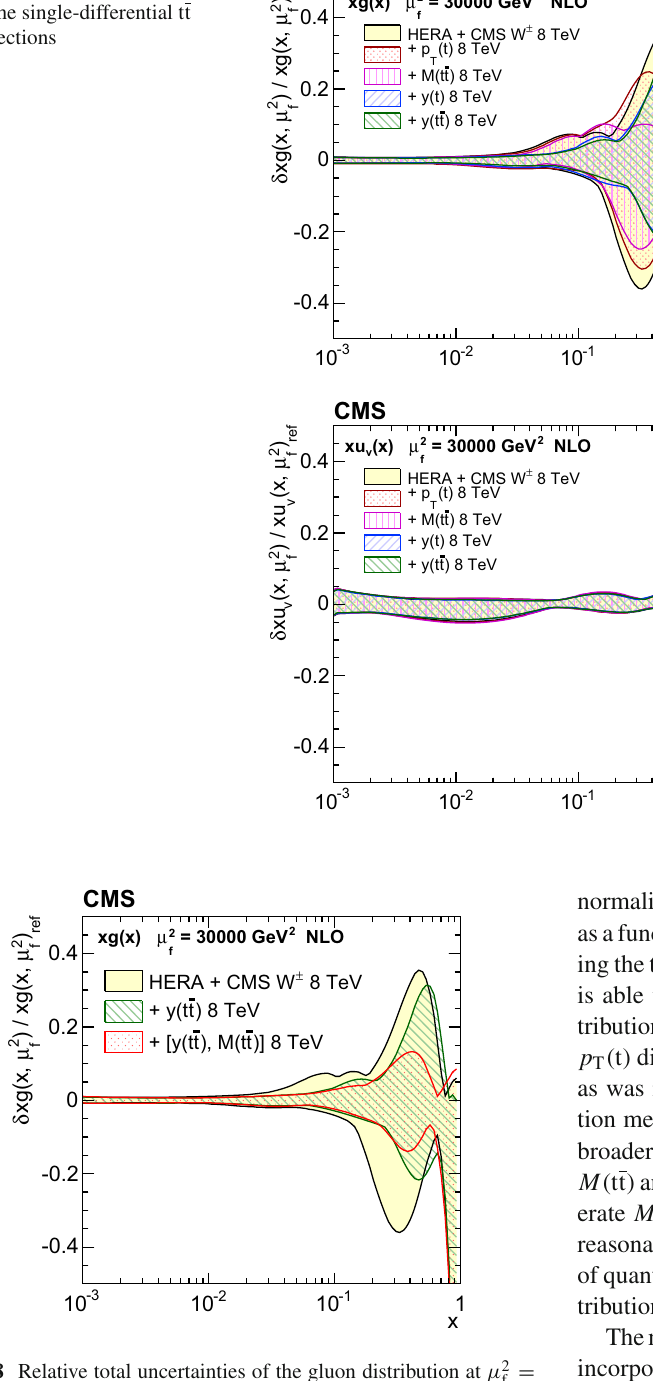
presented. The measurement is performed in the e ± μ ∓ final state, using data collected with the CMS detector at the LHC, corresponding to an integrated luminosity of 19.7 fb − 1 .